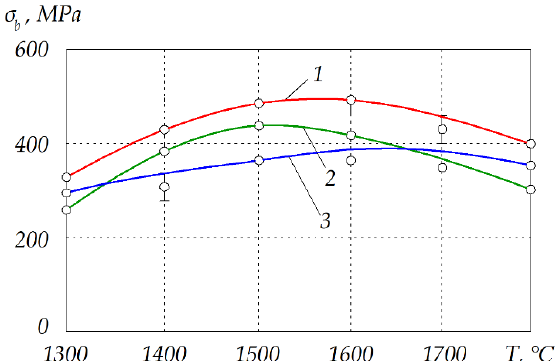
Figure 10. Dependence of flexural strength on sintering temperature of different cermets hot pressed under P = 30 MPa for t = 10 min: 1 —Сr 2 O 3 + (Cr,Al) 2 O 3 + 22 wt.% Cr; 2 —Сr 2 O 3 + (Cr,Al) 2 O 3 + 30 wt.% Cr; 3 —Сr 2 O 3 + (Cr,Al) 2 O 3 + 15 wt.% Cr.